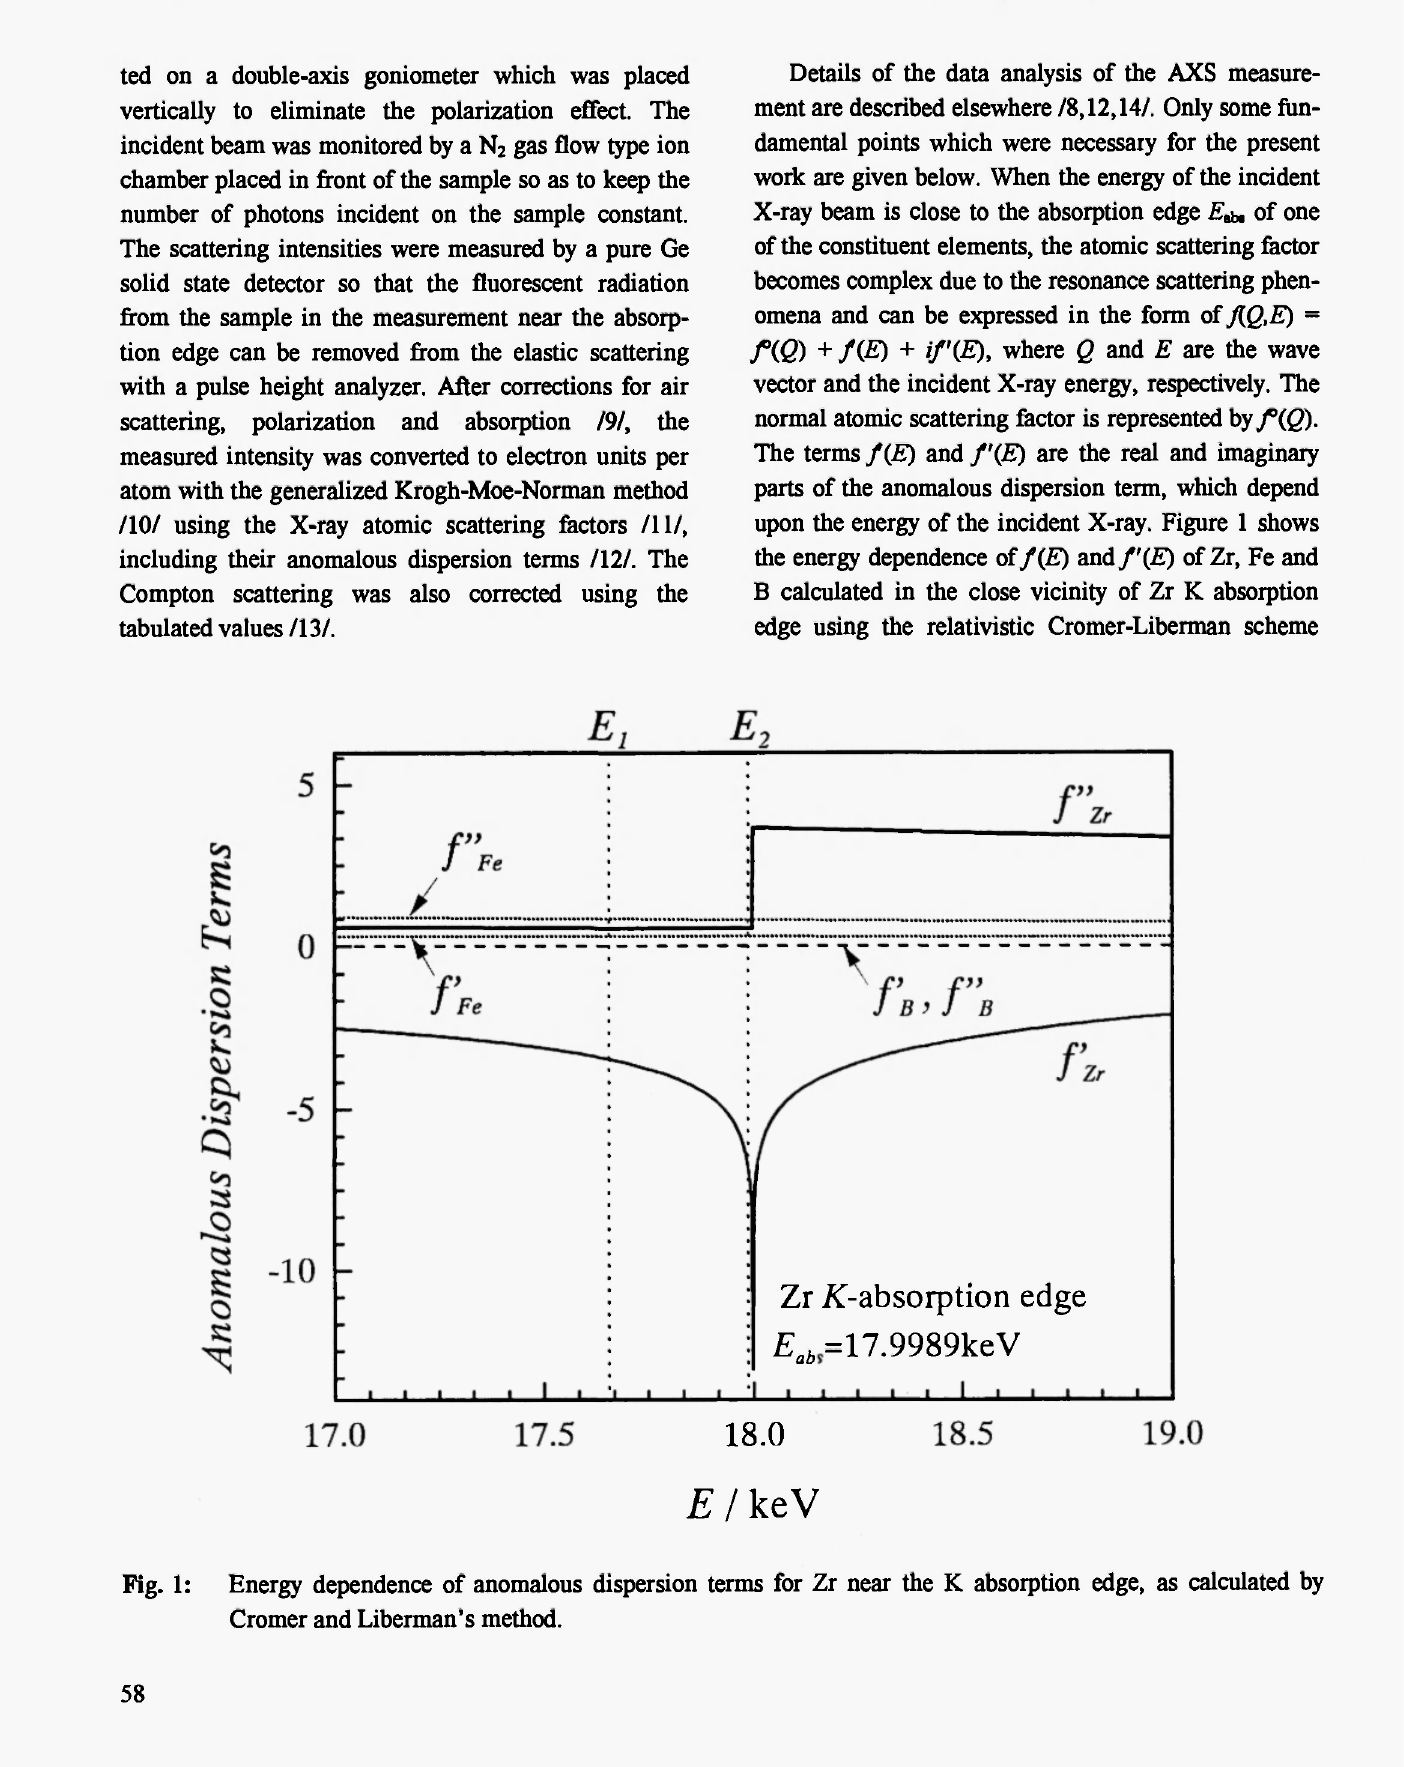
Fig. 1: Energy dependence of anomalous dispersion terms for Zr near the Κ absorption edge, as calculated by Cromer and Liberman's